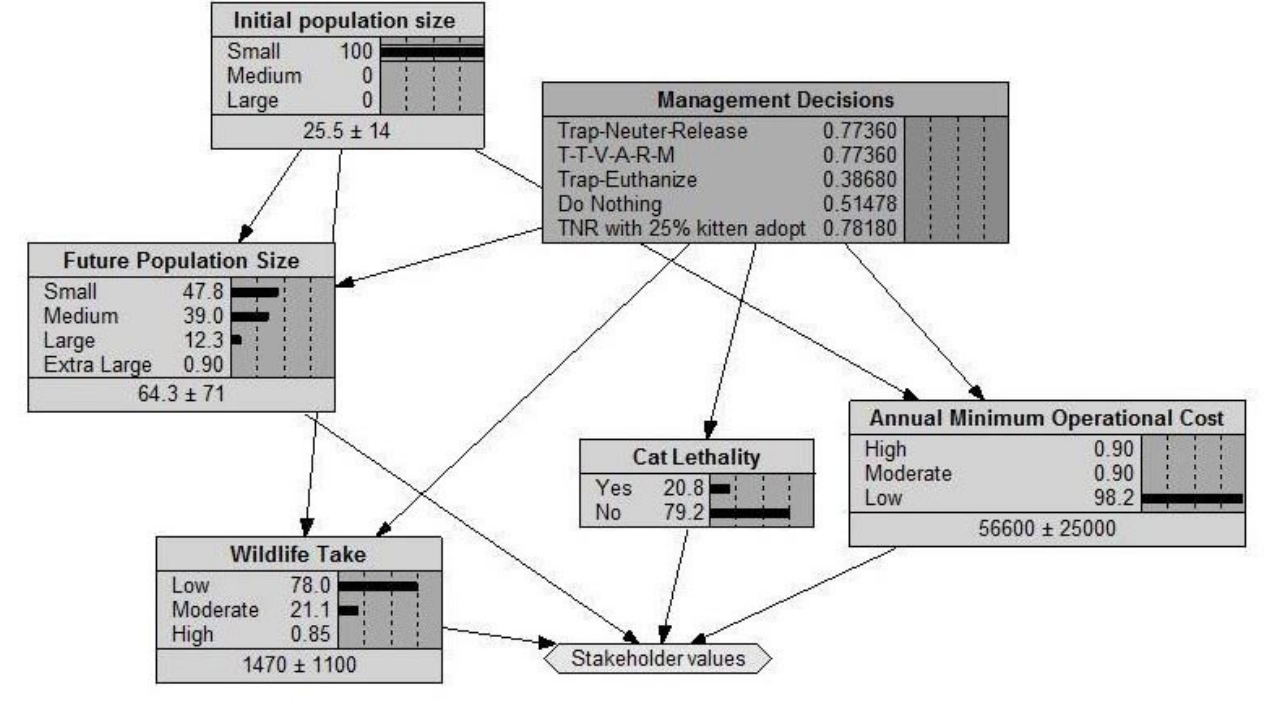
Fig. 3 . The feral cat Bayesian Belief Network. Input: Small population size. Optimal management decision = TNR+ with the highest expected value